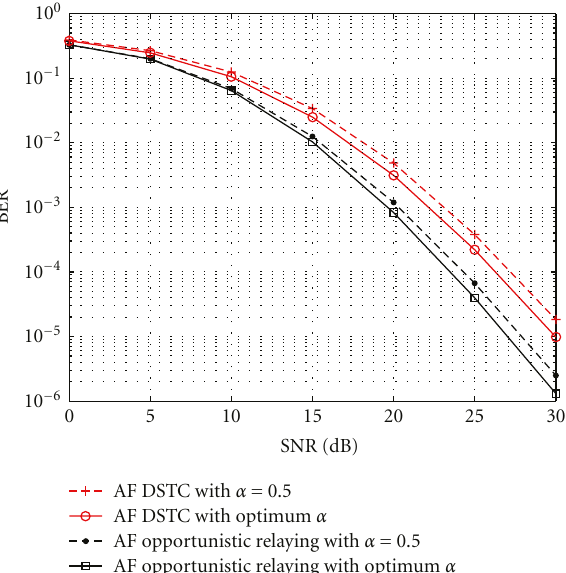
Figure 4: The average BER curves of relay networks employing DSTC and opportunistic relaying in AF mode, when equal power between two phases is compared with α in (7), and with BPSK = 4 σ 2 = 1, and R = 4. signals, σ 2 g i f i